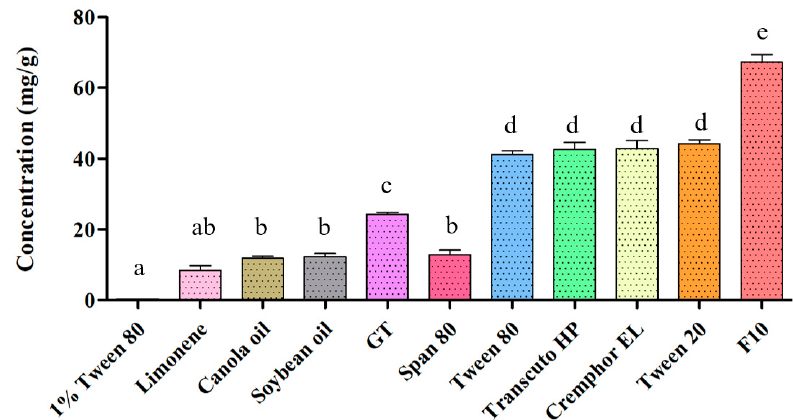
Figure 1. The solubility of sesamin (SSM) in di ff erent solvents. Results are expressed as the mean ± standard error of the mean ( n = 3 for each group). GT is glyceryl trioctanoate, F10 is the composition of GT:Cremophor EL:Tween 20 = 1:1:8 ( w / w / w). Values that do not share the same letter are significantly di ff erent ( p < 0.05).